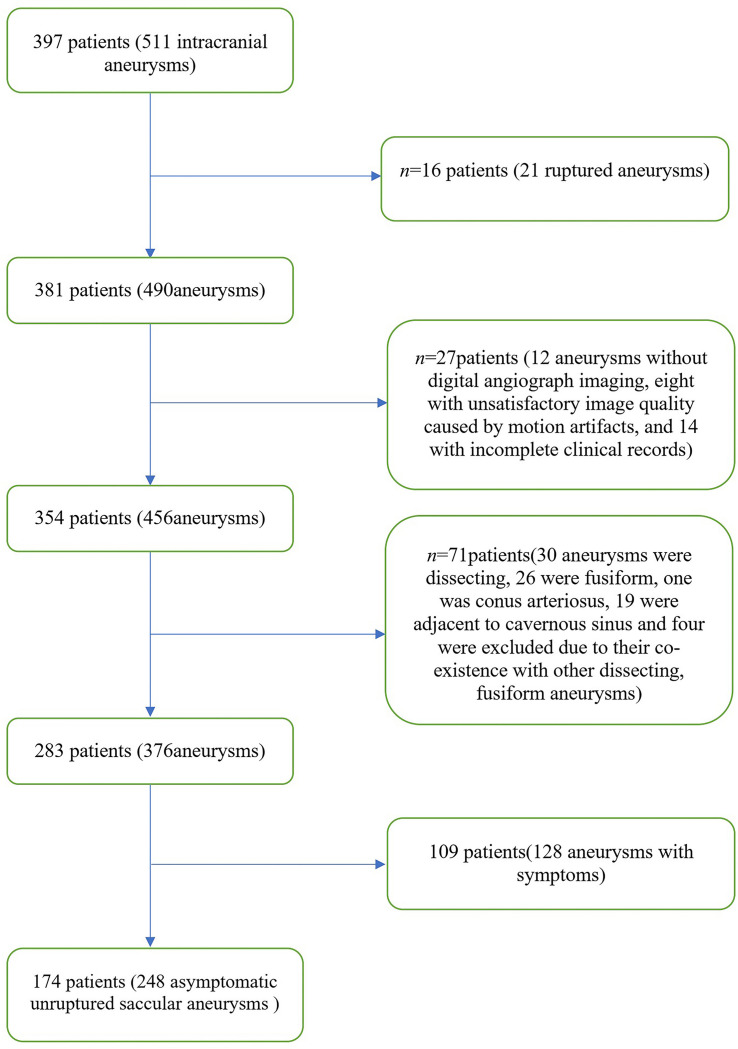
Study flowchart.